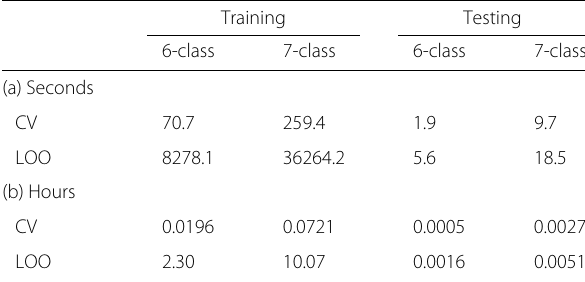
Table 15 Average Runtime per fold (seconds) using CK+